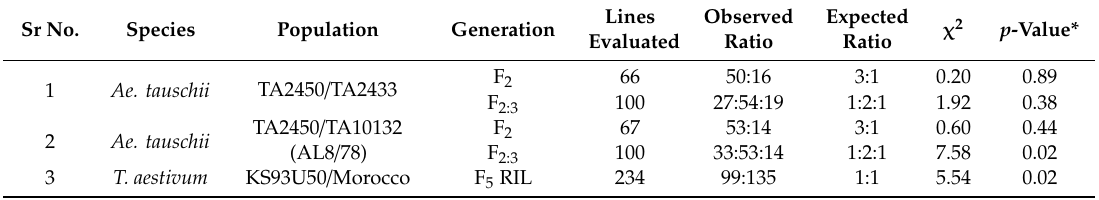
Table 1. Segregation of Lr42 in Ae. tauschii and hexaploid wheat populations against leaf rust race PNMRJ. The observed and expected ratios correspond to the resistance:susceptible in F 2 generations and homozygous resistant:segregating:homozygous susceptible in F 2:3 generations. Sr